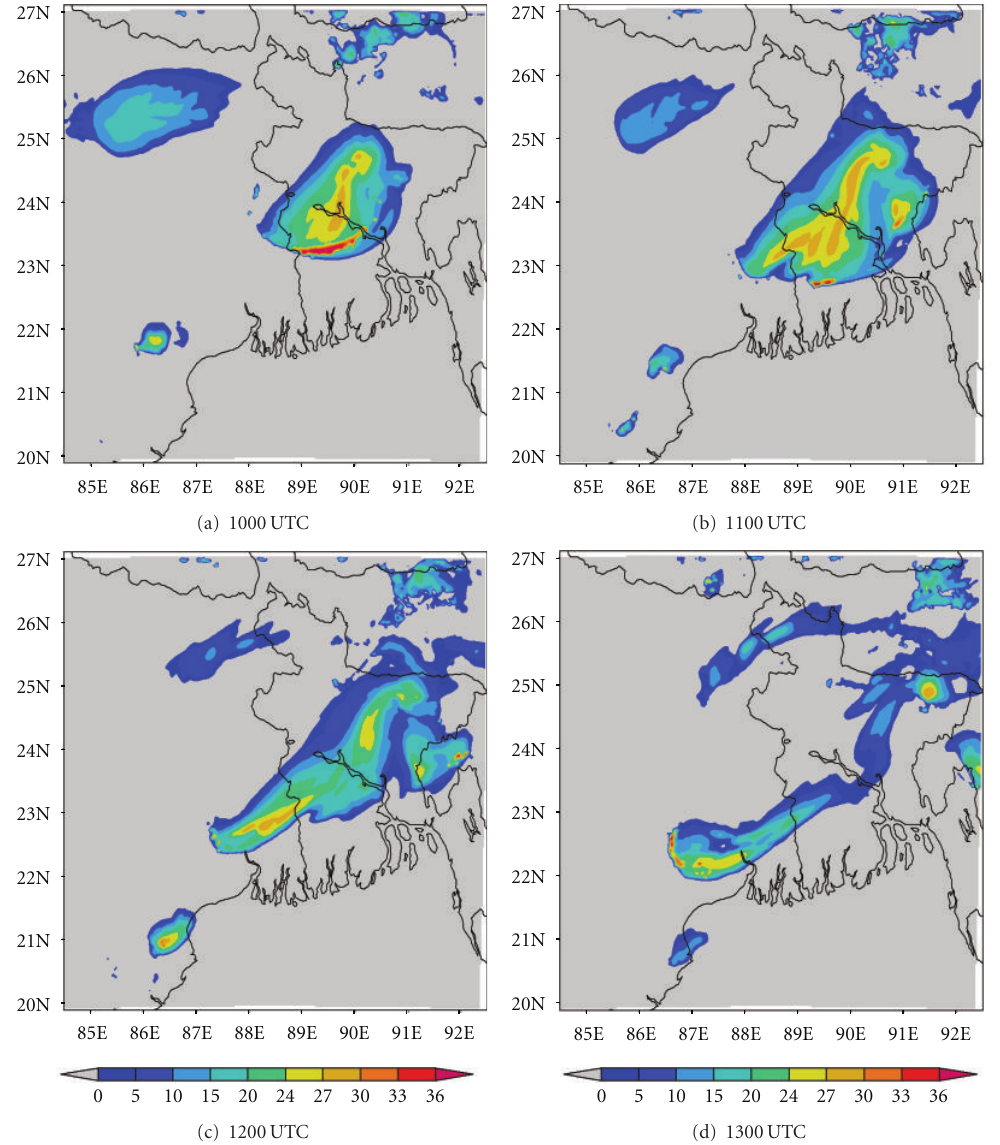
Figure 8: NMM-simulated composite radar reflectivity (dBZ) pictures from 1000 to 1300 UTC on 11, May, 2009.